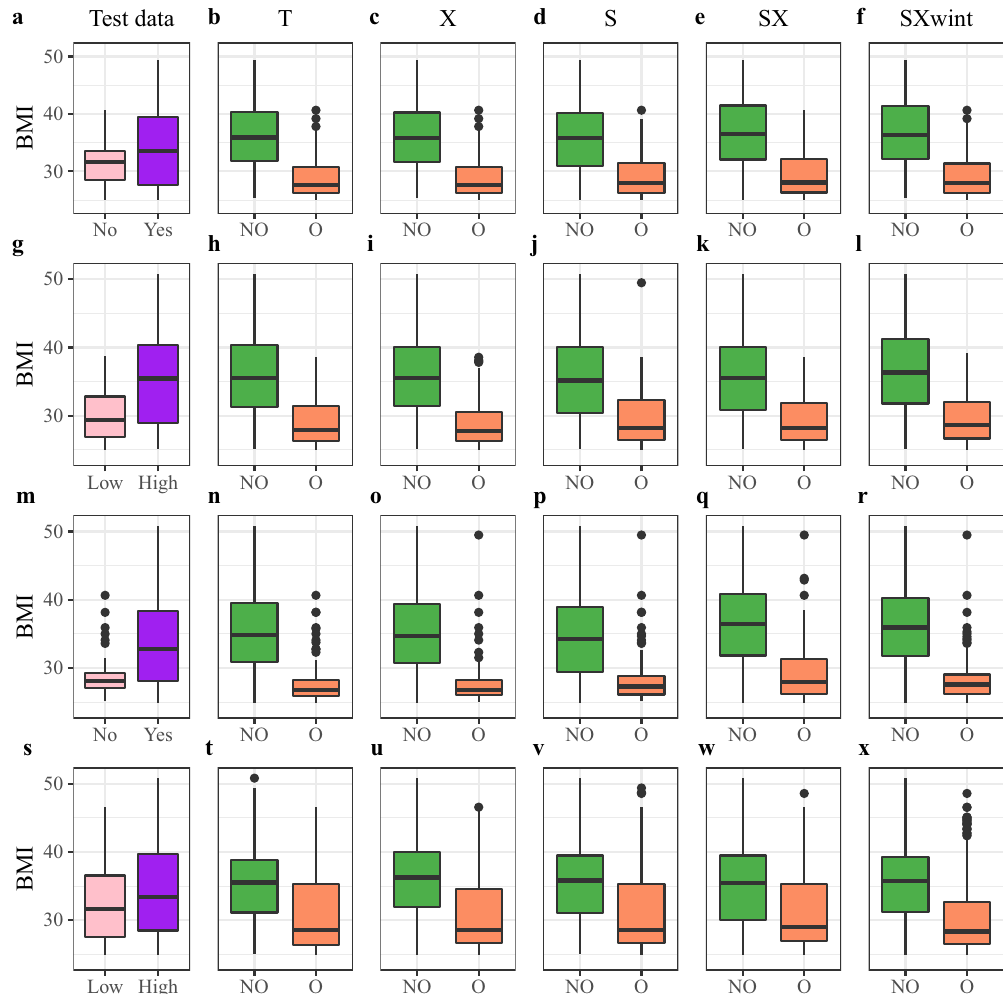
Figure 3. Comparison between BMI distributions in groups; ( a ) Alcohol Yes and No in the testing data, Yes = positive alcohol intake, No = zero alcohol intake, ( b ) Alcohol T learner NO and O, NO = non-optimal group, O = personalized optimal group, ( c ) Alcohol X learner NO and O, ( d ) Alcohol S learner NO and O, ( e ) Alcohol SX learner NO and O, ( f ) Alcohol SXwint learner NO and O, ( g ) Vegetable High and Low in the testing data, High = FCVC > 2 = positive vegetable intake in every meal, Low = FCVC ≤ 2 = no vegetable intake in some meals, ( h ) Vegetable T learner NO and O, ( i ) Vegetable X learner NO and O, ( j ) Vegetable S learner NO and O, ( k ) Vegetable SX learner NO and O, ( l ) Vegetable SXwint learner NO and O, ( m ) HCF Yes and No in the testing data, HCF = high caloric food, Yes = high frequency of HCF intake, No = low frequency of HCF intake, ( n ) HCF T learner NO and O, ( o ) HCF X learner NO and O, ( p ) HCF S learner NO and O, ( q ) HCF SX learner NO and O, ( r ) HCF SXwint learner NO and O, ( s ) Water High and Low in the testing data, High = CH 2 O > 2 = daily water intake greater than 2 liters, Low = CH 2 O ≤ 2 = daily water intake less than or equal to 2 liters, ( t ) Water T learner NO and O, ( u ) Water X learner NO and O, ( v ) Water S learner NO and O, ( w ) Water SX learner NO and O, ( x ) Water SXwint learner NO and